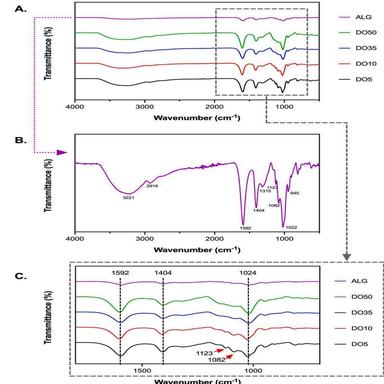
FT-IR spectra for unmodified (ALG, purple line) and oxidized alginates with DO5 (black line), DO10 (red line), DO35 (blue line) and DO50 (green line): A. Full FT-IR spectra in the range of wavenumber 400–4000 cm− 1 . B. Characteristic spectrum of unmodified alginate (wavenumber 400–4000 cm− 1 ), identified bands from left to right are: 3221 cm− 1 (O–H stretching) and 2916 cm− 1 (aliphatic C–H stretching), 1592 cm− 1 (asymmetric COO- stretching),1404 cm− 1 (symmetric COO- stretching), 1315 cm− 1 (C–O stretch